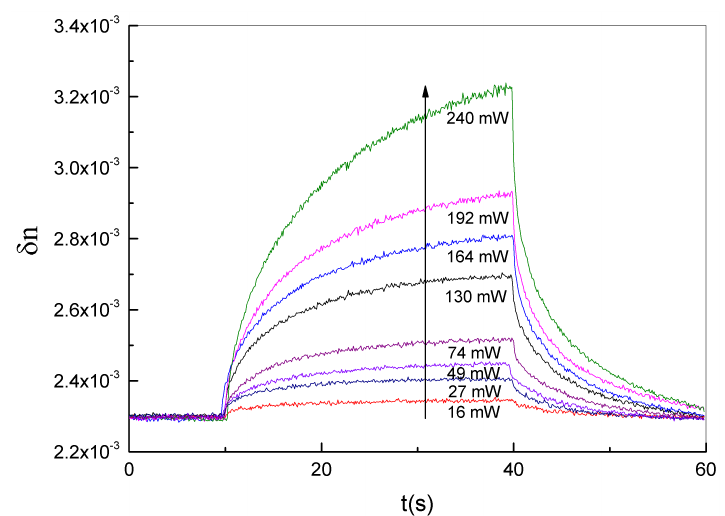
Figure 3. Change of the refractive index contrast δ n as function of time for different irradiation power levels from 16 mW to 240 mW @ λ = 457